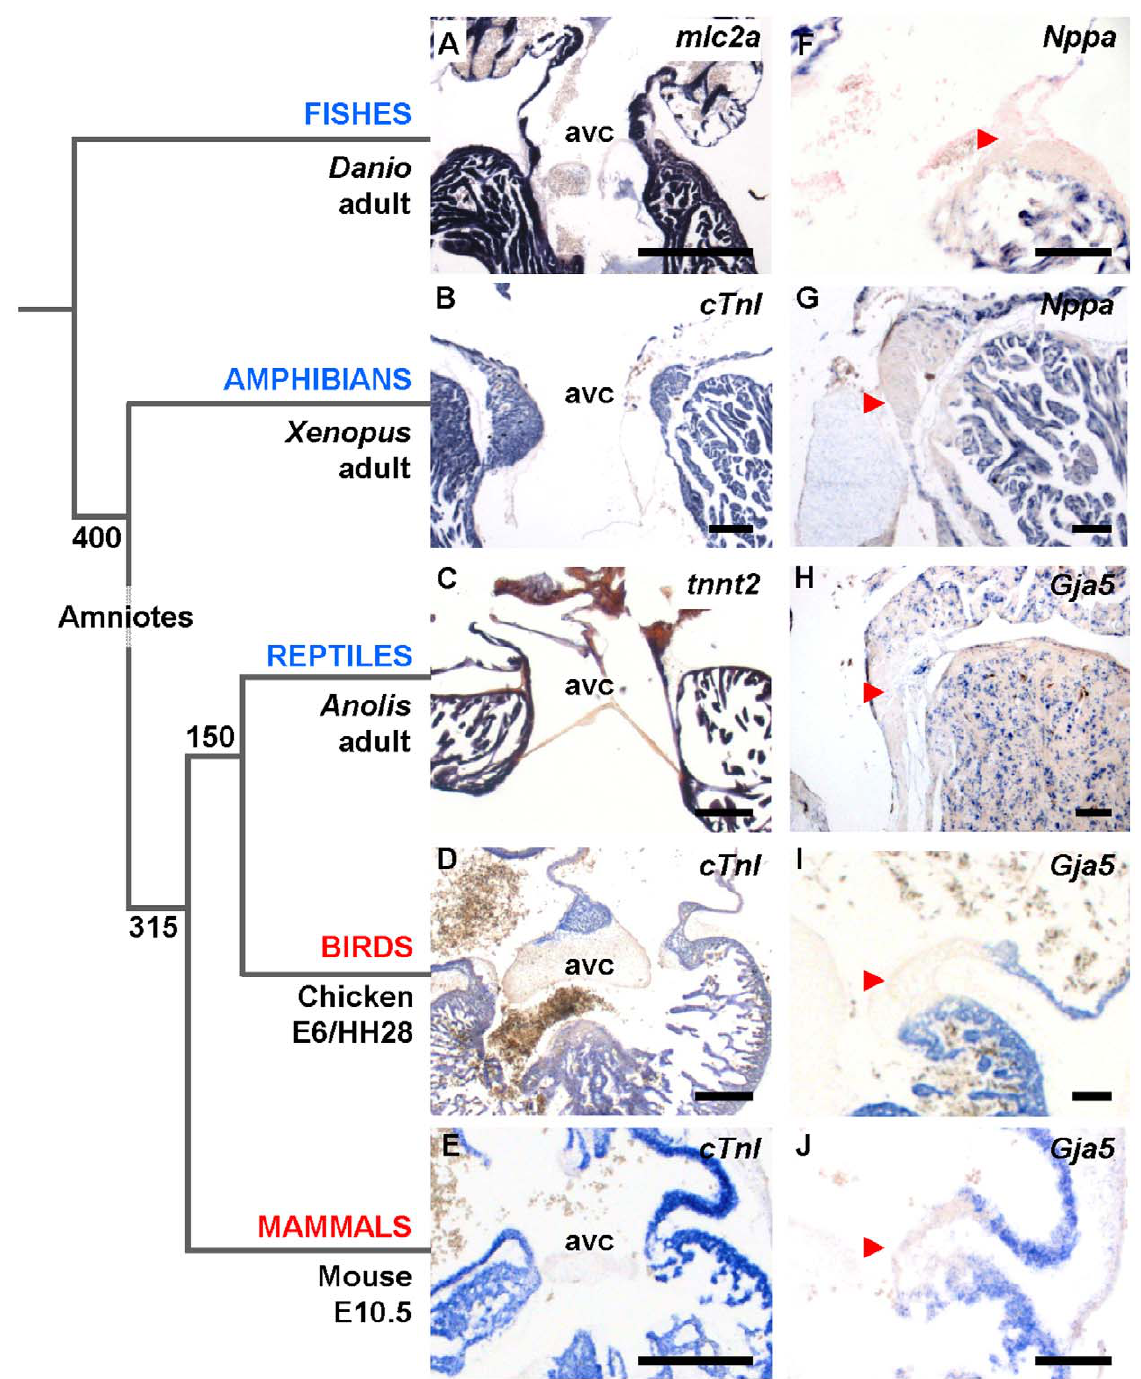
Figure 3. The phenotype of the slow propagating atrioventricular canal is evolutionary conserved. Numbers in the phylogenetic tree indicate time in millions of years since major splits in tetrapod evolution. (A–E) The hearts of mature ectotherms (blue) and embryonic endotherms (red) maintain complete muscular connection in the atrioventricular canal (avc). (F–J) Markers of fast propagating chamber myocardium ( Nppa and Gja5 ) are absent from the atrioventricular canal (arrowheads). Note that the specimen in H is contracted, obscuring the spongy design otherwise visible. Scale bars in (A–E), 300 m m; (F–J), 100 m m.